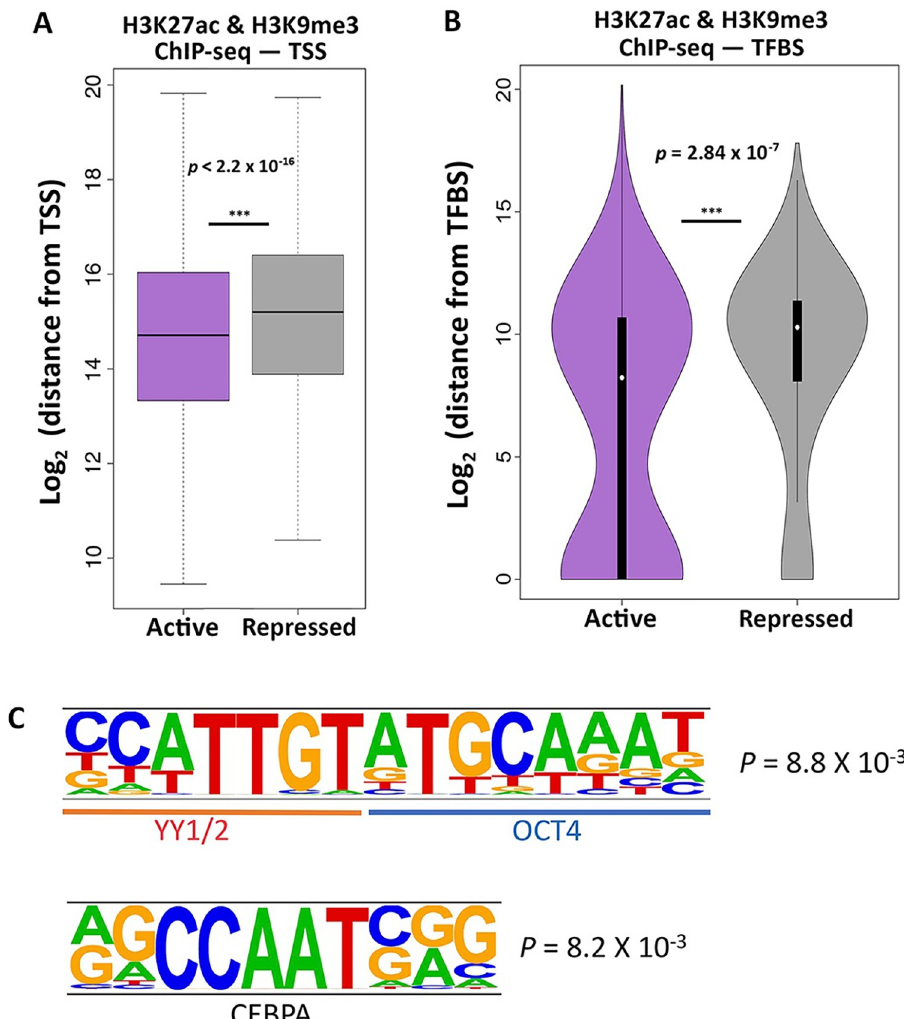
Fig 2. Specific genomic features characterize the de-repressed SVAs. (A) SVAs in an active configuration are approximately 10 kb closer to TSS than SVAs in a repressed configuration (Wilcoxon’s Rank Sum Test p < 2.2 x 10 − 16 ). (B) Active SVAs are significantly closer to, and directly overlap with, TFBS three times more than repressed SVAs (Wilcoxon’s rank-sum test p = 2.84 x 10 − 7 ). (C) Motif analysis performed on the de-repressed SVAs shows enrichment for consecutive YY1/2 and OCT4 motifs. A CEBPA motif was also